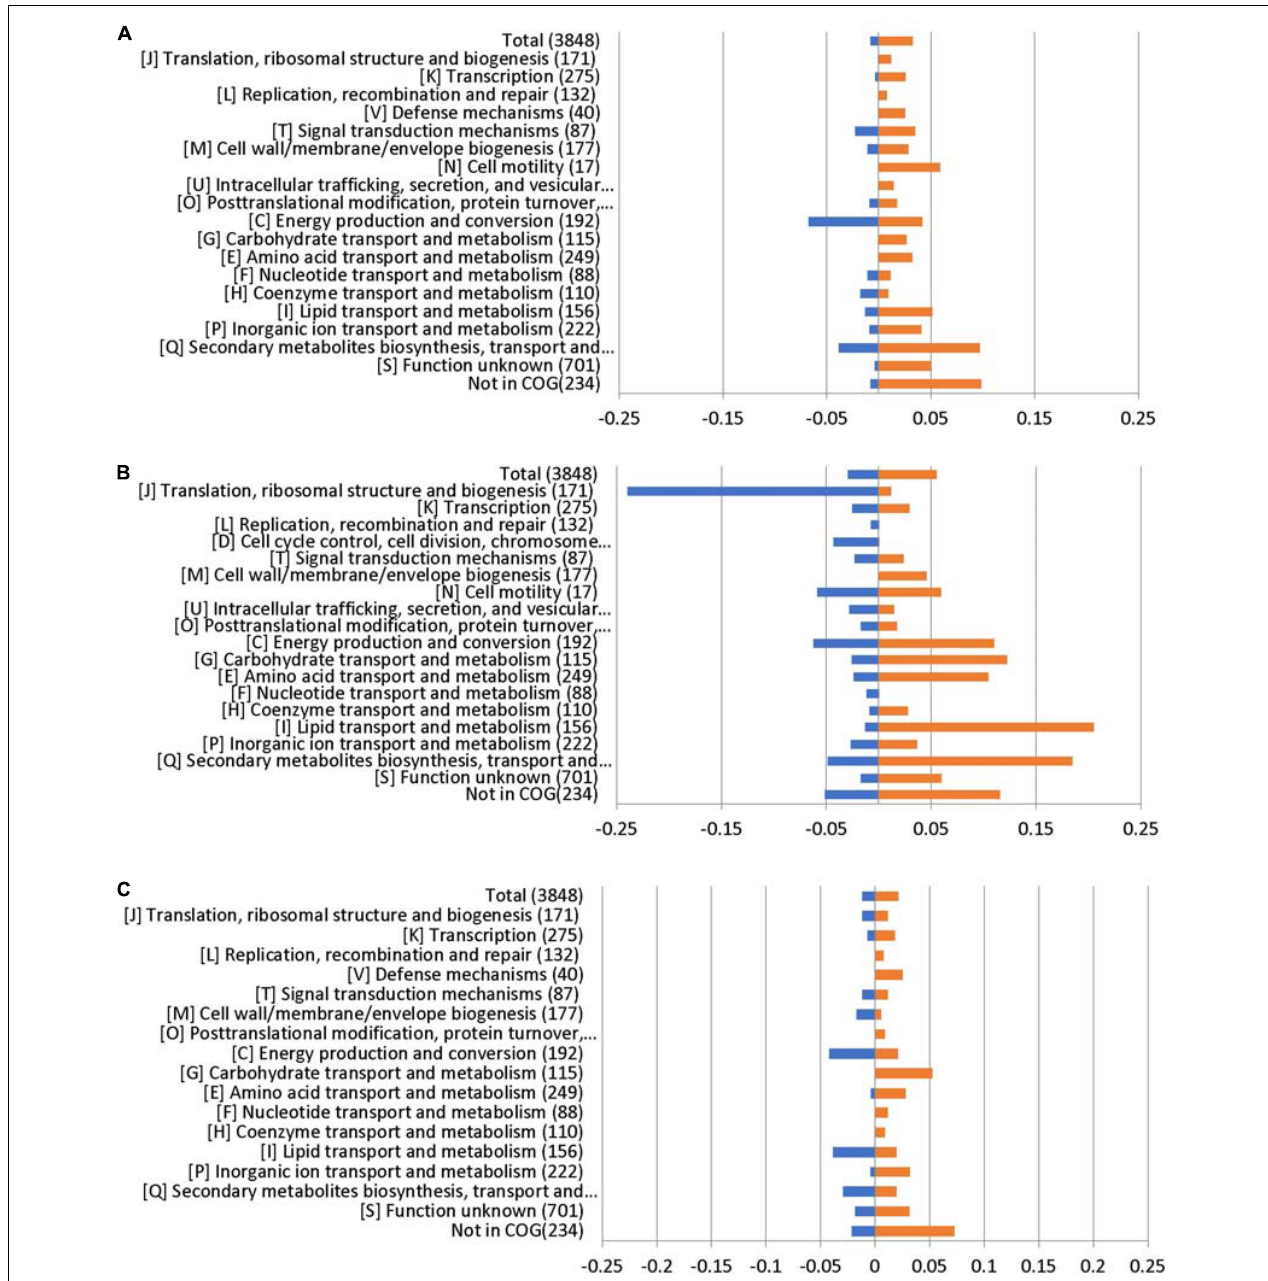
FIGURE 9 | RNA sequencing results displayed by COG enrichment for differentially regulated genes. COG enrichment analysis was performed by dividing the percentage of genes upregulated or downregulated for each category by the percentage of genes in that category across the whole genome. (A) (cid:49) abaI ; (B) (cid:49) abaR ; and (C) (cid:49) abaIR